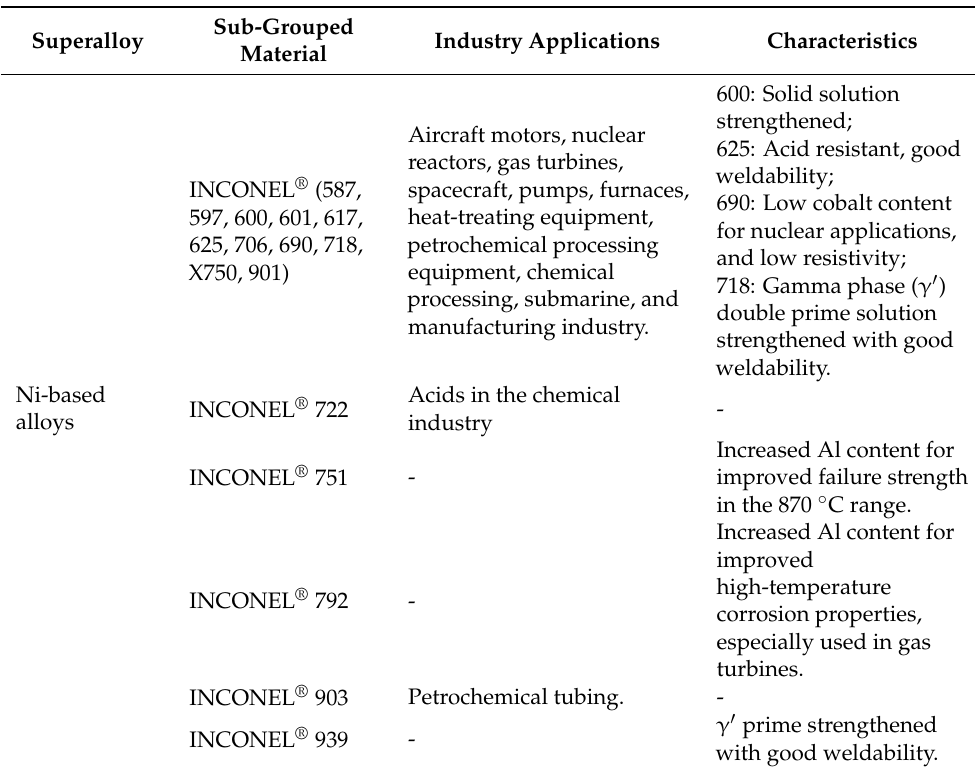
Table 2. Summary of applications and characteristics of some nickel-based superalloys (adapted from